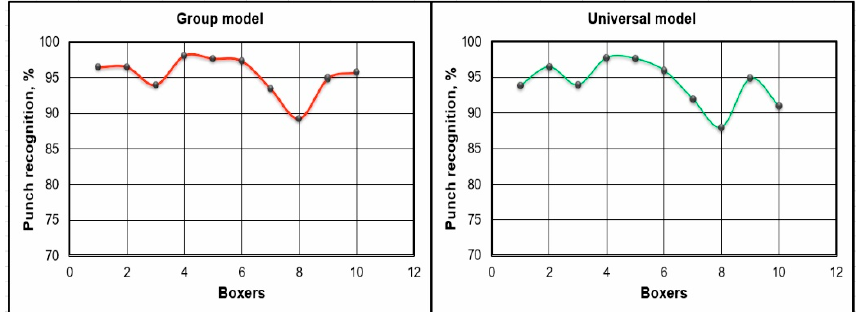
Figure 11. Graphs showing the level of recognition of punches of a group of boxers with 2–3 years of training experience.